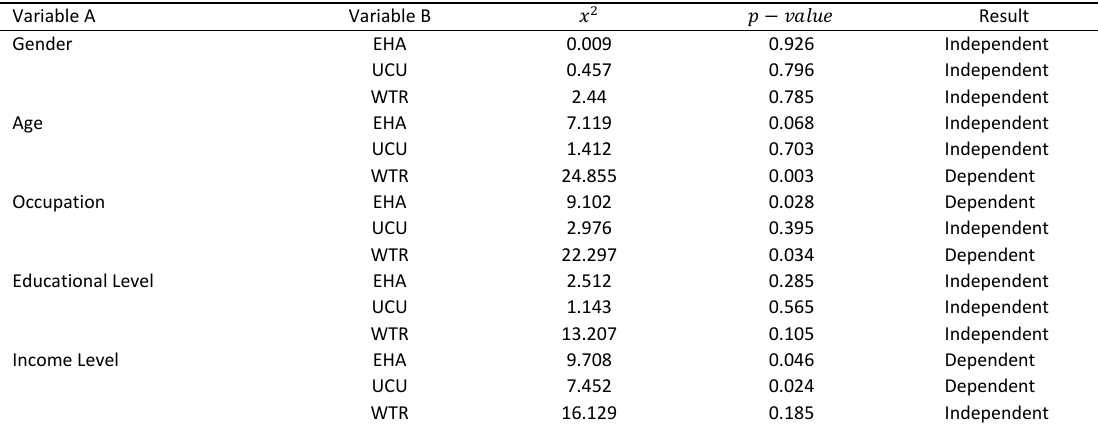
Table 2: Chi-square independence test results